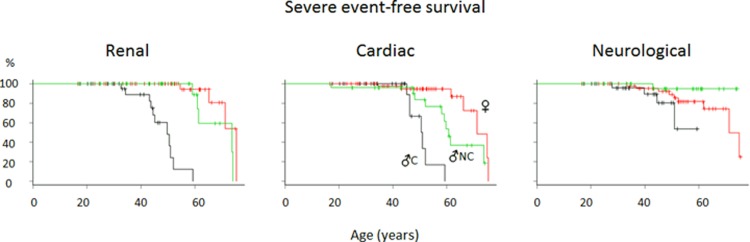
Renal, cardiac and neurological severe event-free survival curves (black: Classical group males, green: Nonclassical group males, red: Females).